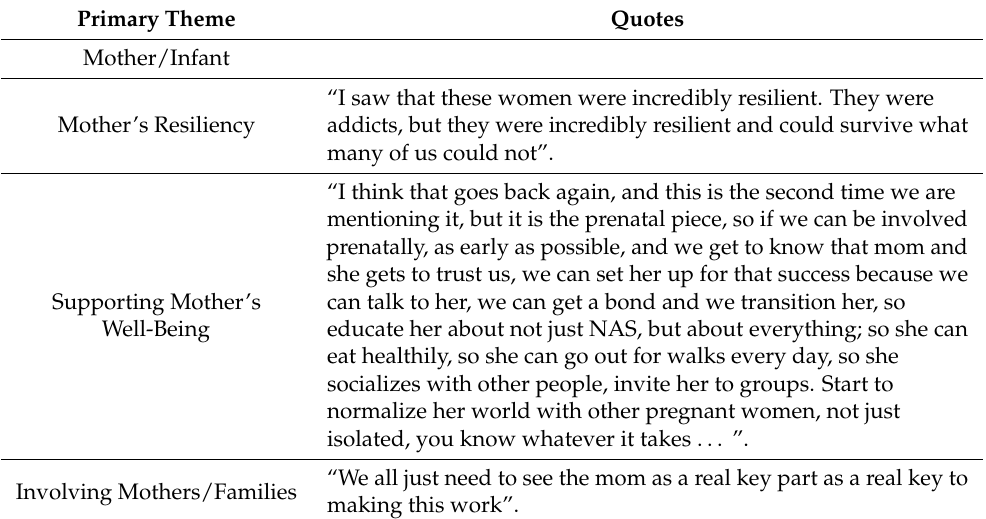
Table 2. Facilitators to